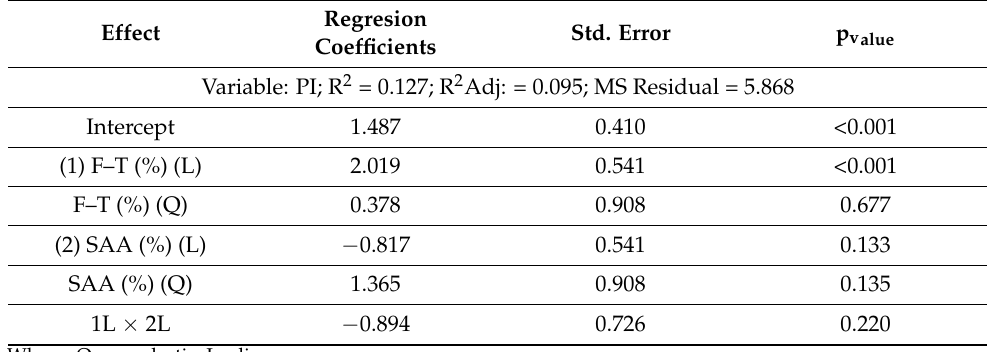
Table 8. Evaluation of the significance (ANOVA) of the factorial impact (F–T wax and SAA) on PI.